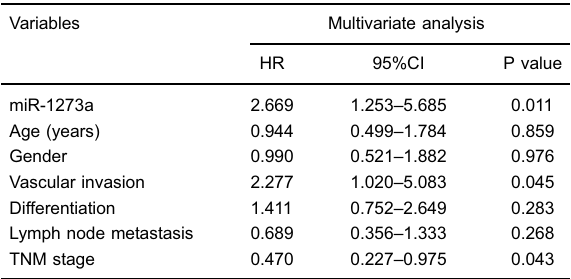
Table 2. Multivariate Cox regression analysis for miR-1273a in colon cancer patients.